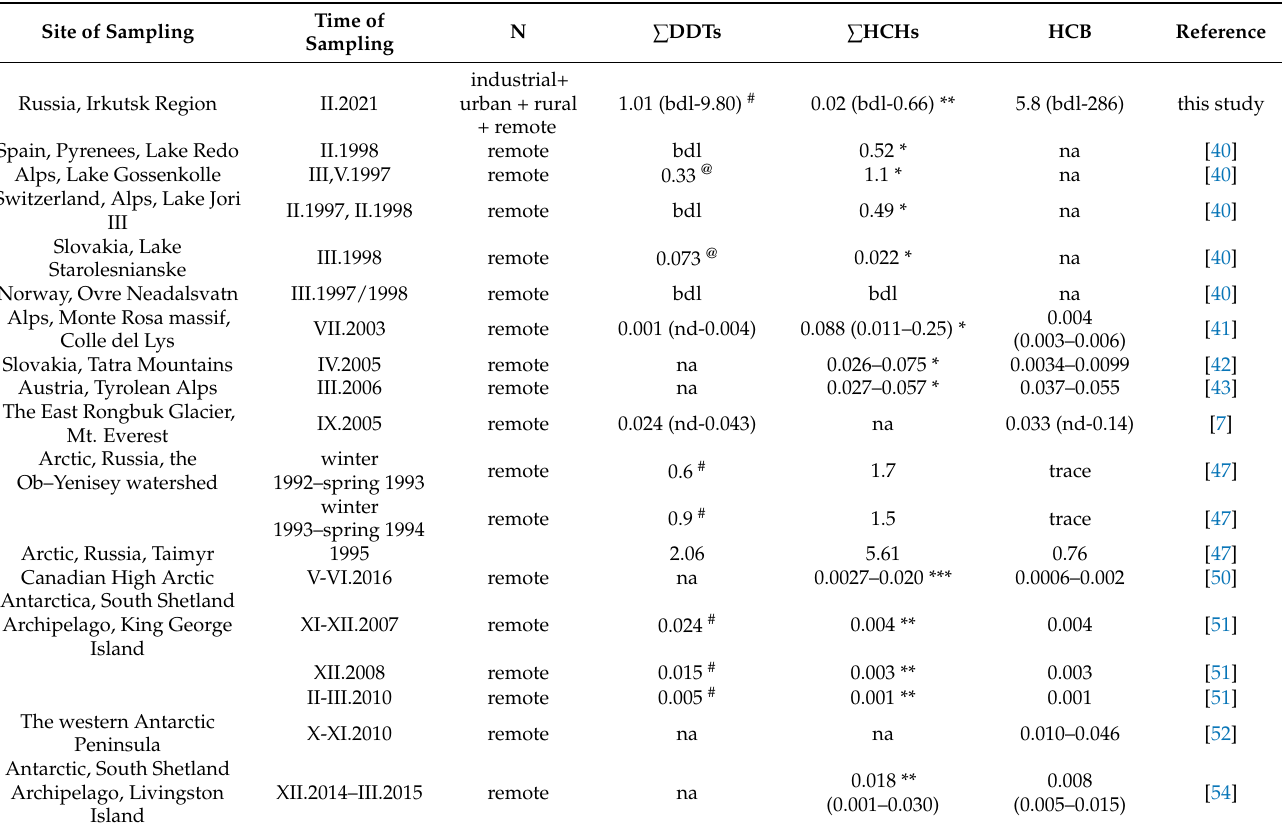
Table 3. The comparison of OCP levels in snow water from different areas of the world